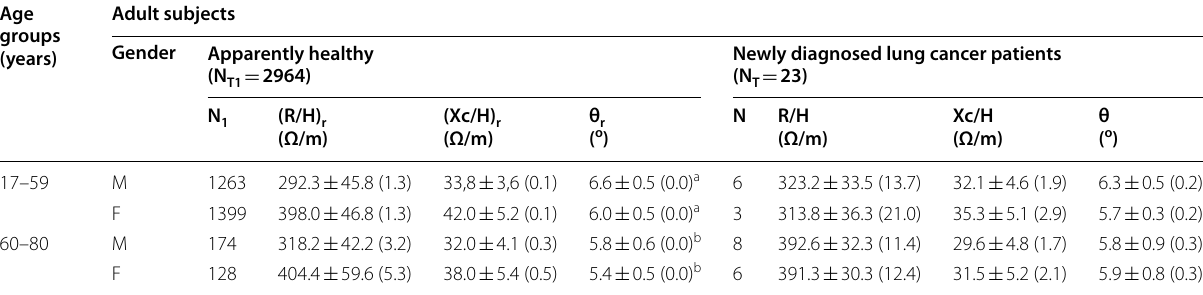
Table 3 Mean standard deviation (standard error of the mean) of R/H, Xc/H and θ (newly diagnosed lung cancer adult patients) and ± (R/H) , (Xc/H) and θ (apparently healthy subjects), by age group and r r r